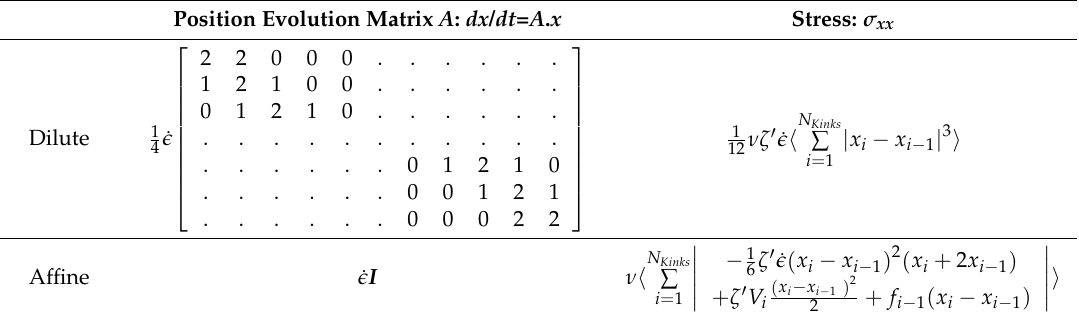
Table 1. Evolution equations for vector x of kink positions under dilute and affine assumptions. Position Evolution Matrix A : dx / dt = A . x Stress: σ xx